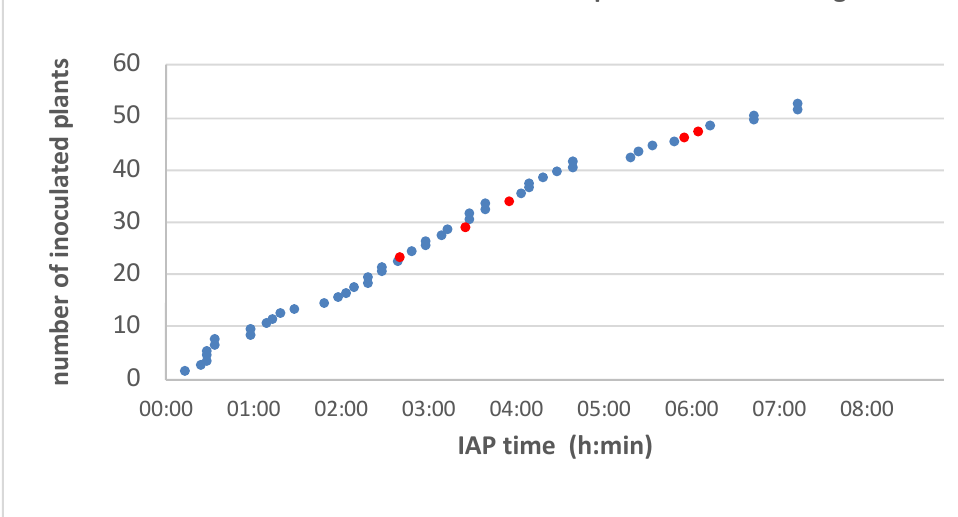
Figure 1. Inoculation access period durations tested for transmission of GLRaV 1 by L2 nymphs of Parthenolecanium corni from a natural population of Nothalten. Times for successful transmissions are indicated by red dots, and no transmissions by blue dots.